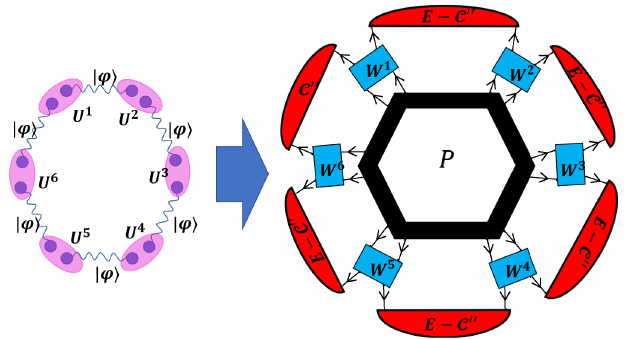
FIG. 9. Left: A 2 m -partite quantum state built by acting with random two-qubit unitaries U 1 ; … ; U over many copies of the m bipartite state j ϕ i . Right: Contraction of 2 → 2 and 2 → 1 connectors used to detect the Bell nonlocality of the associated 2 m -partite box (in